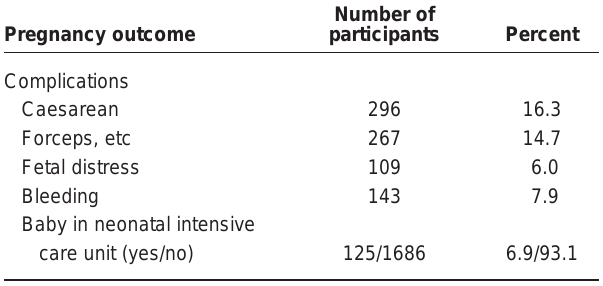
TABLE 8 Prevalance of microbiology findings at different visits in the Edmonton Perinatal Study